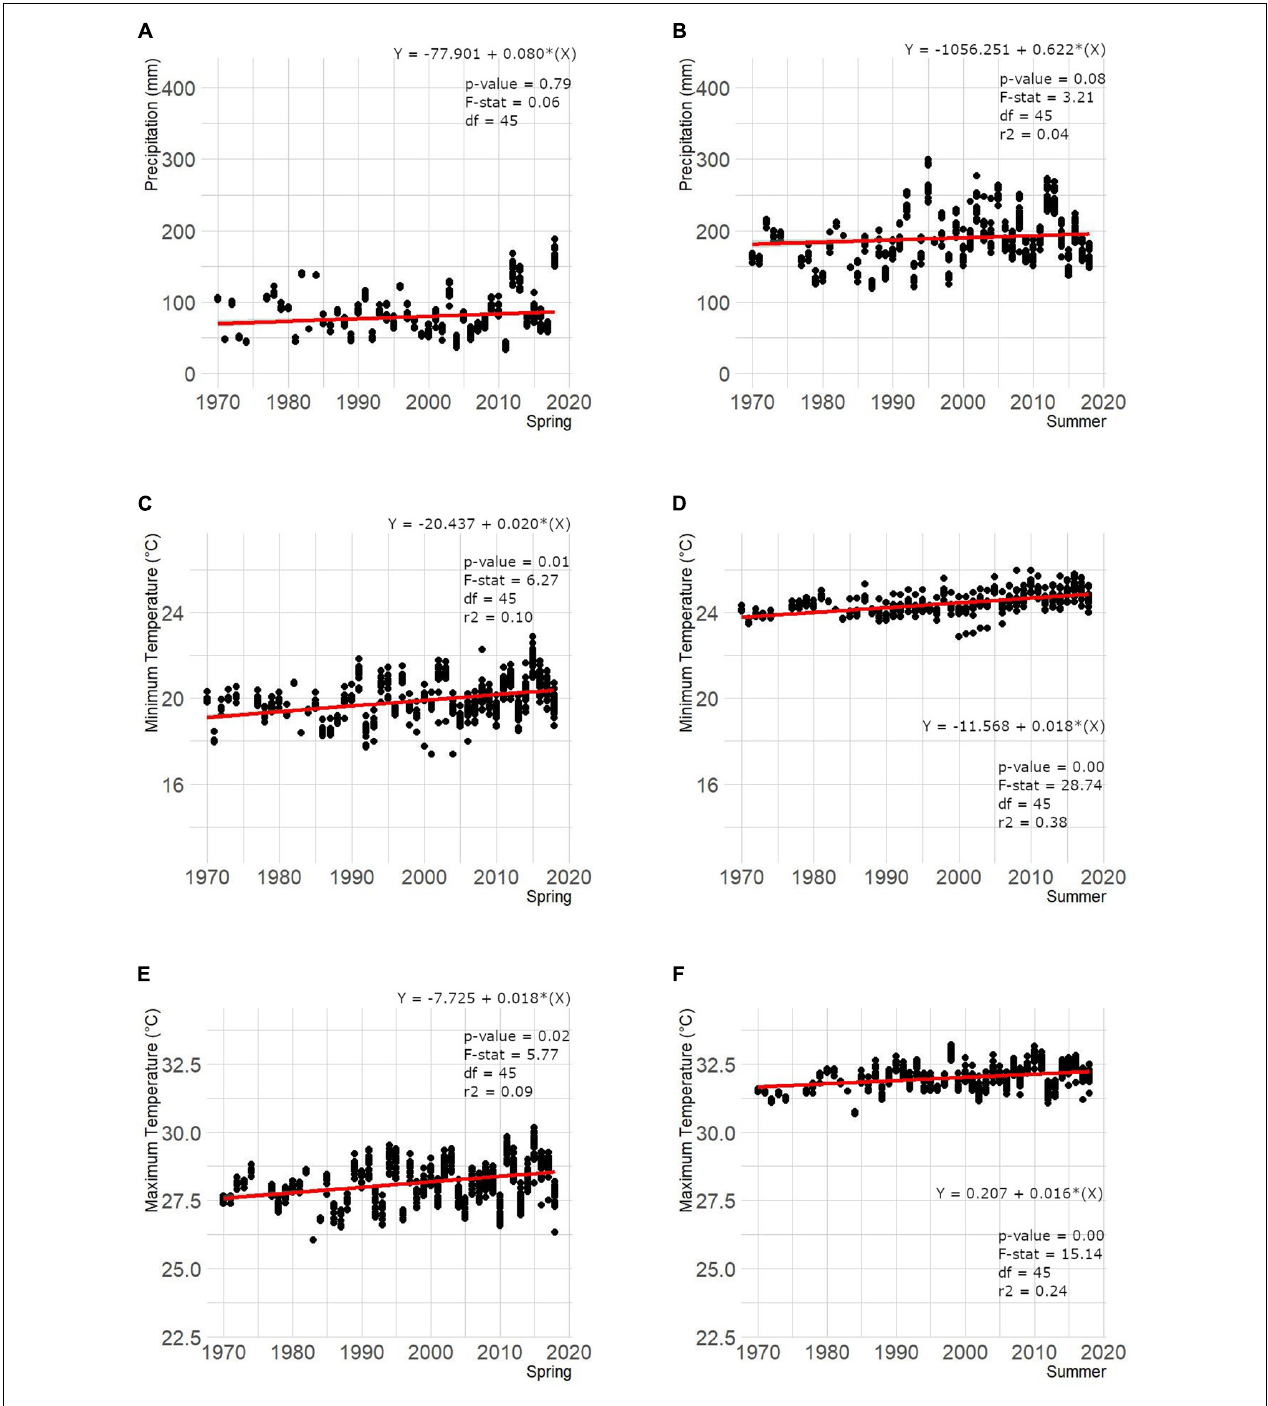
FIGURE 4 | Mean precipitation (A,B) , minimum (C,D) and maximum (E,F) temperature by season [spring (March, April, and May) and summer (June, July, and August)] from 1970 through 2018 reported across American crocodile ( Crocodylus acutus ) nesting areas in South Florida, United States. There is overall weak-to-strong evidence for a positive trend in all variables across time except for mean spring precipitation.